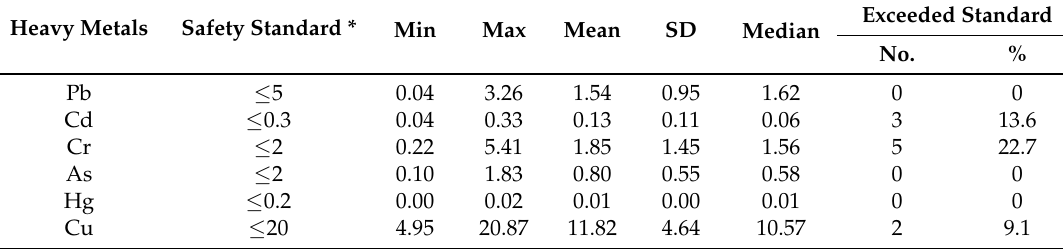
Table 10. Analysis of heavy metal contents in P. notoginseng rhizome ( n = 22, mg · kg − 1